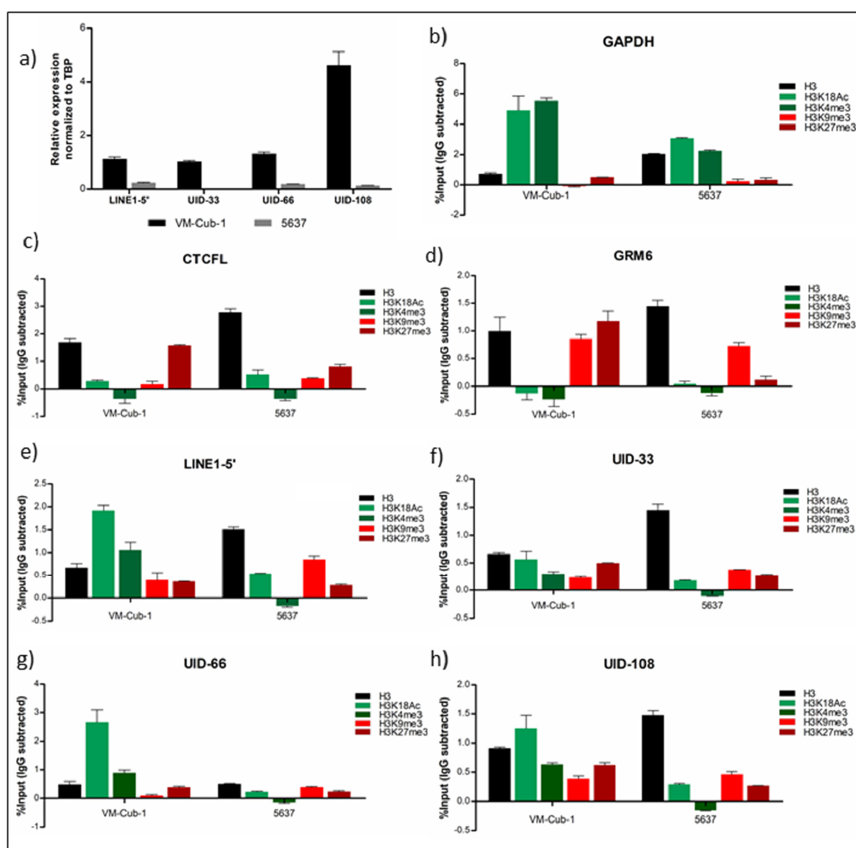
Figure 5. Histone modifications at intact L1s. ChIP-qPCR was performed in the cell lines VM-Cub-1 and 5637. ( a ) Expression of overall LINE-1, UID-33, UID-66 and UID-108 in VM-Cub-1 and 5637 cells as determined by qRT-PCR. ChIP was validated by qPCR for GAPDH ( b ), CTCFL ( c ) and GRM6 ( d ). ( e )–( h ) ChIP results for promoters of overall LINE-1 ( e ), UID-33 ( f ), UID-66 ( g ) and UID-108 ( h ). All ChIP results were calculated as percentages of input and the value of the respective normal IgG control (mouse or rabbit) was subtracted, which may yield negative values in cases of low enrichment. Mean values of one of two independent experiments are shown; each PCR was performed in